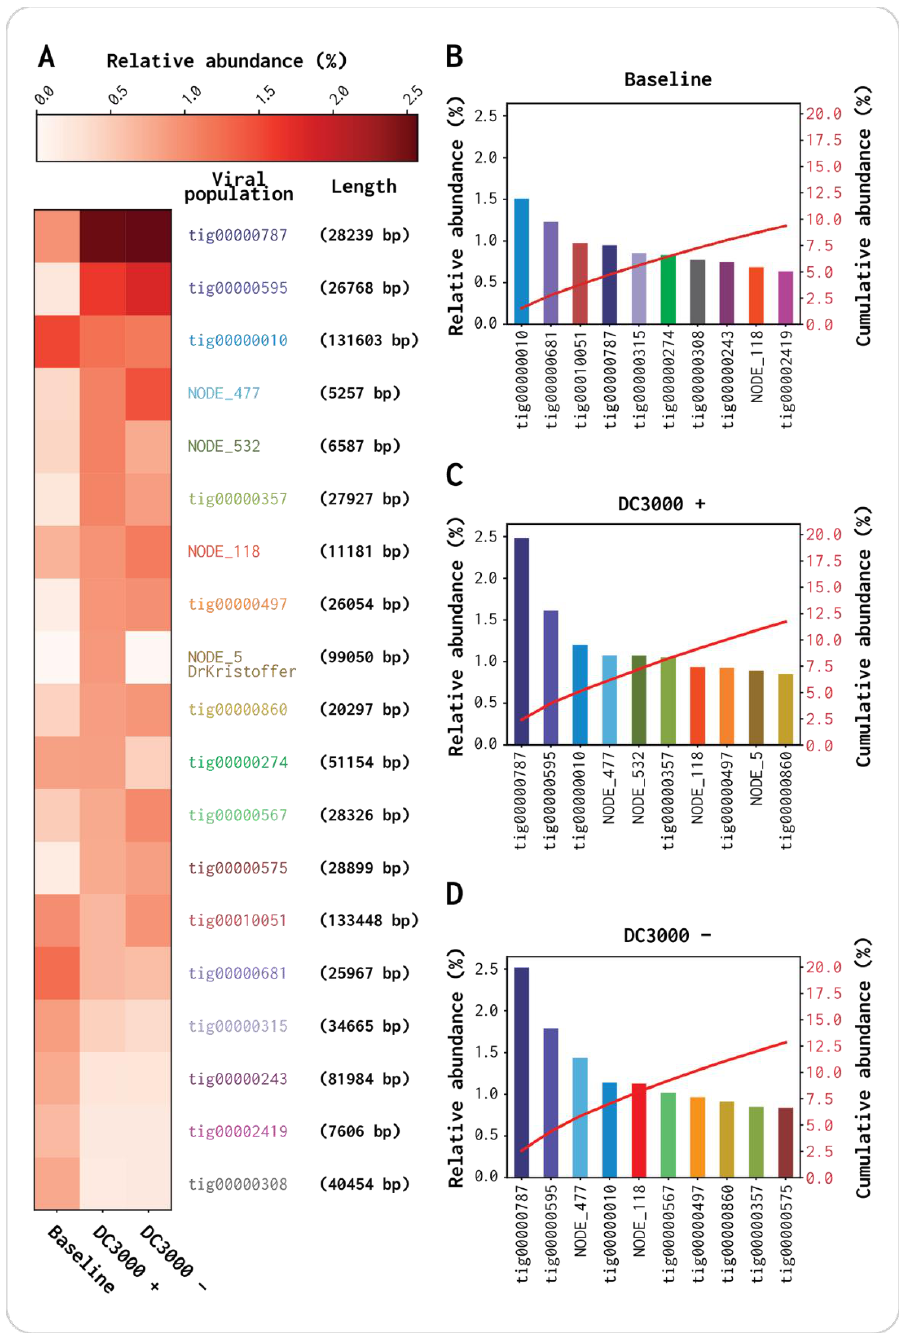
Figure 4. Abundance comparison of 10 most abundant contigs for the three viromes (baseline, DC3000 +, and DC3000 − ). All contigs were putative viral, as identified by VirSorter2, and passed through filtering; they had <40% query coverage to the bacterial database and were >5 kbp: ( A ) heatmap of read-abundance correspondent to the 10 contigs from each of the three viromes; ( B – D ) relative abundance percentage (left Y -axis) and cumulative abundance percentage (right Y -axis) of the 10 most abundant contigs in the baseline virome; ( B ) baseline virome; ( C ) DC3000 + virome; ( D ) DC3000 − virome. It has to be noted that we did not account for whether these contigs could come from the same viral genome as fragments from the assembly.